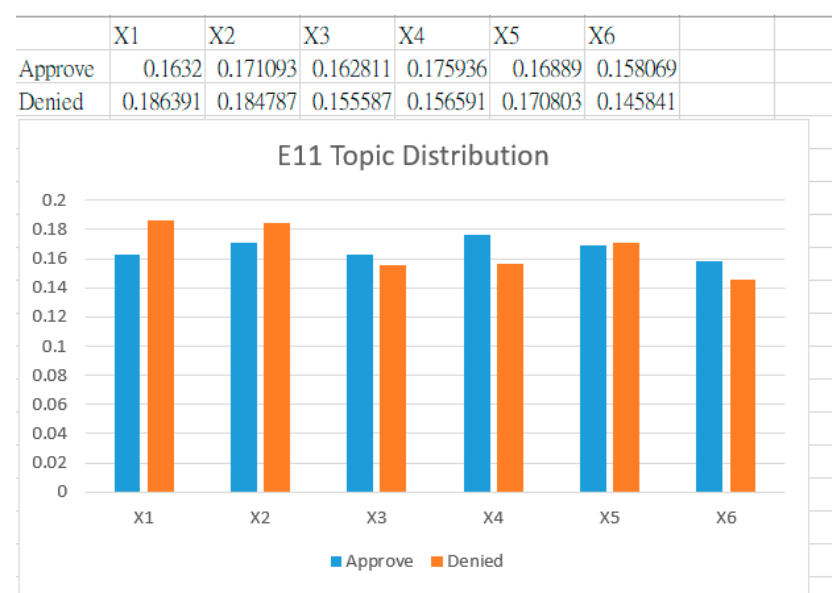
Figure 10. Topic deducted (approved/denied) distribution (E11).